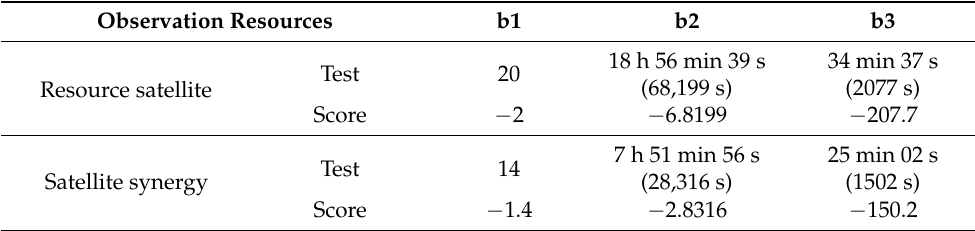
Figure 4. Schematic diagram of GF-resource satellite joint access to regional targets. Table 5. Improvement of regional target observation